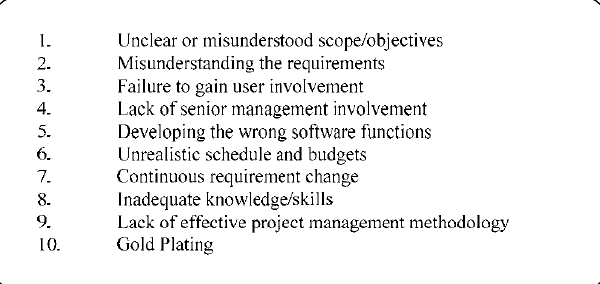
Figure 4: Addison and Vallabh’s ‘top ten’ software risk items. (Addison & Vallabh (2002)